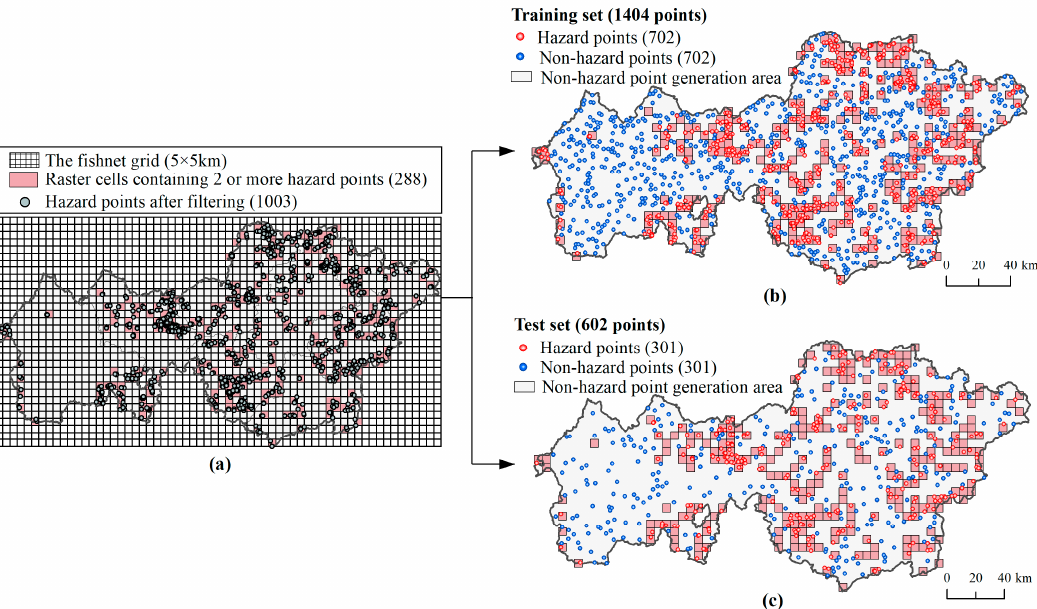
Figure 5. Data preprocessing method based on the fishnet grid and the generation of the training and test sets. ( a ) Data preprocessing method based on the fishnet grid. ( b ) Generating the training set. ( c ) Generating the test set.